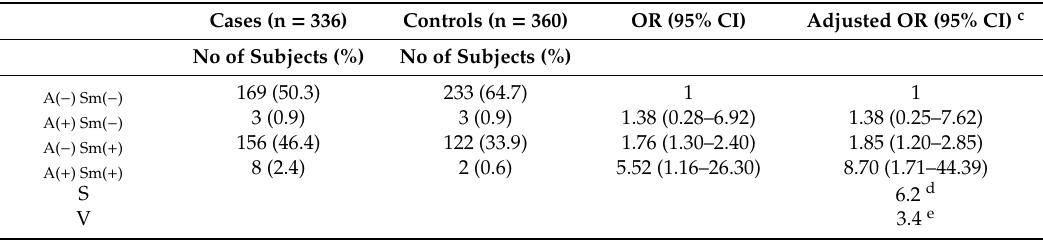
Table 6. Odds ratio and adjusted odds ratio of the association between the combination of occupational asbestos exposure and smoking with lung